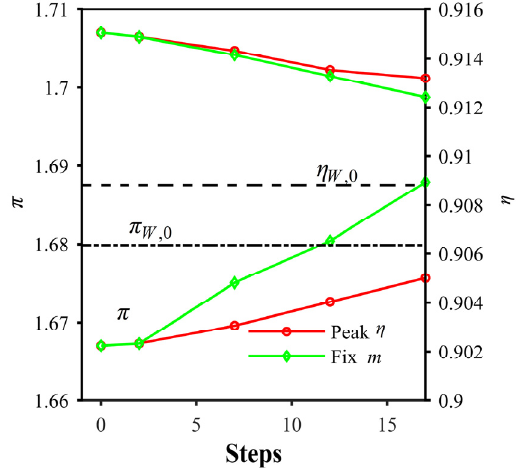
Figure 14. Performance variation during modification.